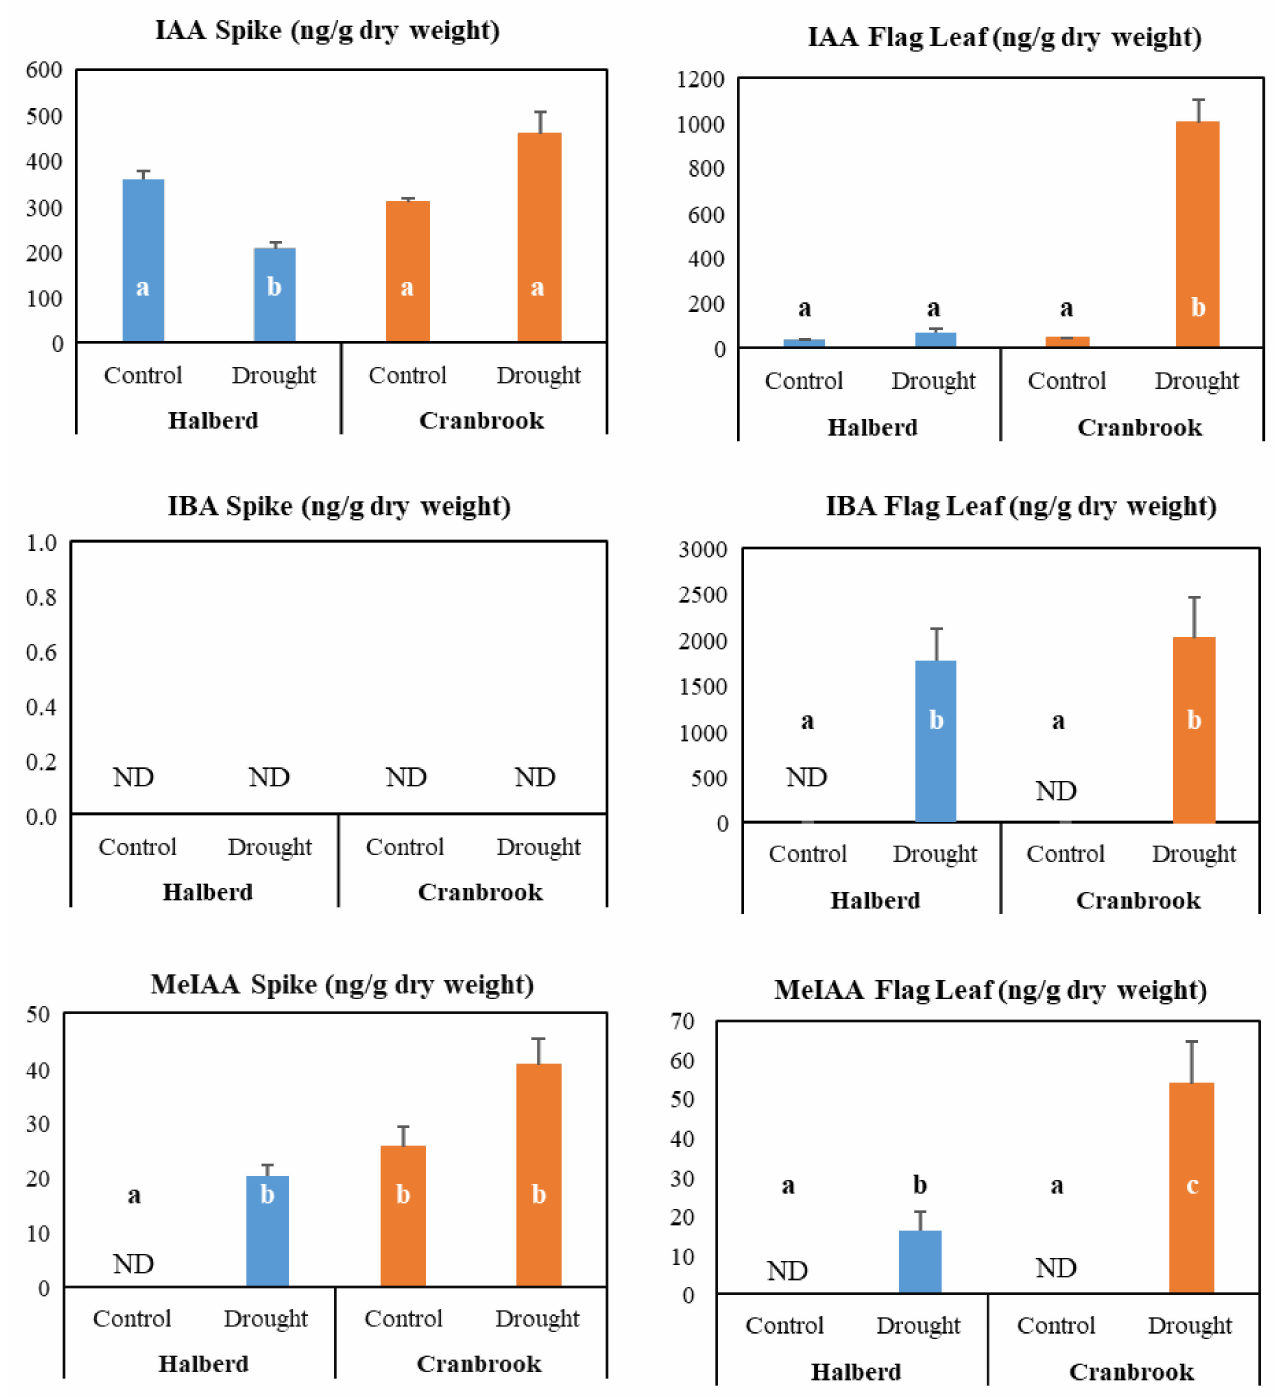
Figure 8. Measurements of indole-3-acetic acid (IAA), indole-3-butyric acid (IBA) and methyl-indole-3-acetic acid (MeIAA) in control and drought-stressed Halberd and Cranbrook flag leaves and spikes. Average ABA levels are expressed in ng/g dry weight (Y-axis). Three repeats were used for each measurement and error bars are standard errors. Hormone levels that are significantly different compared the Halberd unstressed control and and compared to the other samples in the graph are labelled with different letters ( t -test; p < 0.05). For samples labelled “ND” hormone levels were not